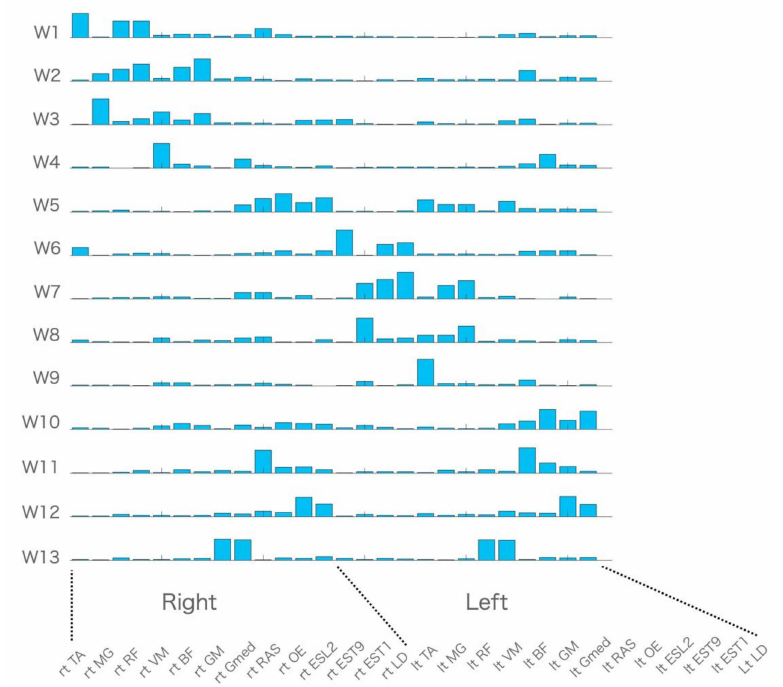
Figure 1. Muscle synergies of all tasks. Centroids of the hierarchical clustering performed on the muscle synergies of all tasks across ten